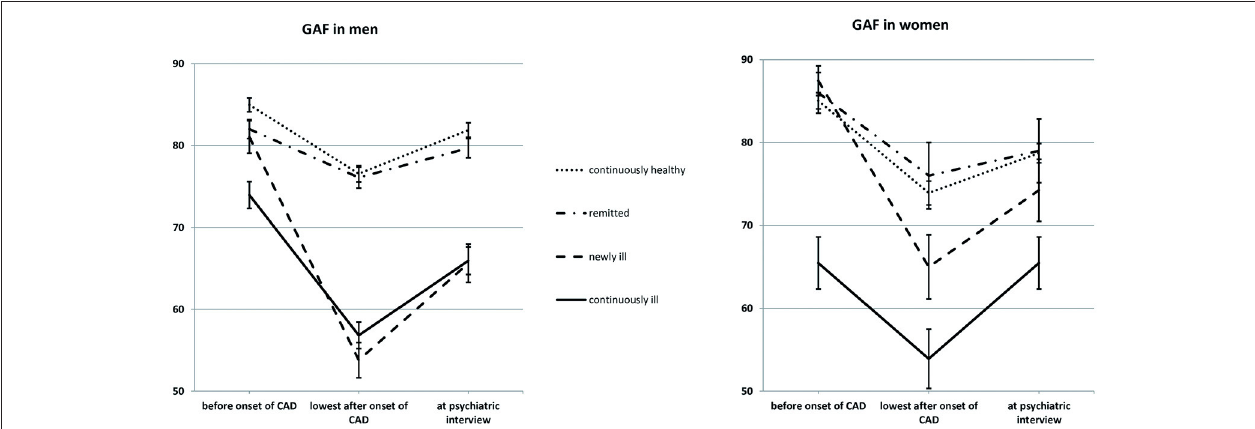
FIGURE 1 | Psychosocial functioning as a function of gender and mental health. Sample size: 387 men and 125 women. Mean GAF scores are given; errors bars indicate standard errors. GAF, Global Assessment of Functioning; CAD, coronary artery disease; Continuously healthy, never met the criteria for a mental disorder before or after the onset of CAD (50.0%); Remitted, met the criteria for a mental disorder before but not after the onset of CAD (21.3%); Newly ill, met the criteria for a mental disorder after, but not before the onset of CAD (12.7%); Continuously ill, met the criteria for a mental disorder both before and after the onset of CAD